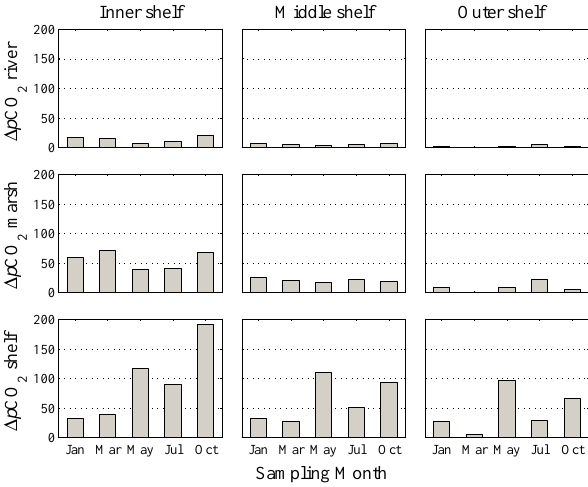
Fig. 8. Seasonal changes of area-averaged 1p CO 2 (river), (refer- enced to 23.11 ◦ C), 1p CO 2 (marsh), and 1p CO 2 (shelf).